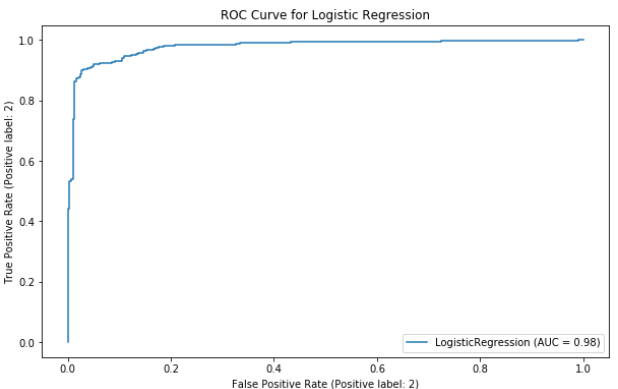
Figure 12. Receiver-operating characteristic curve for LoGit classification performance on validation subset of 600 images.